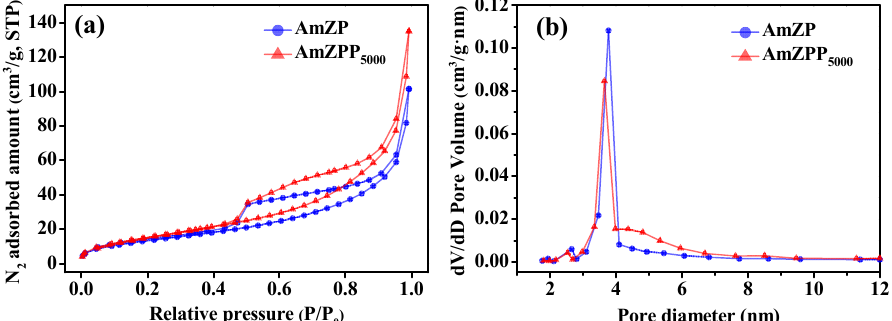
Figure 5. BET curves ( a ) and diagram pore sizes distribution ( b ) of AmZP and AmZPP 5000 .